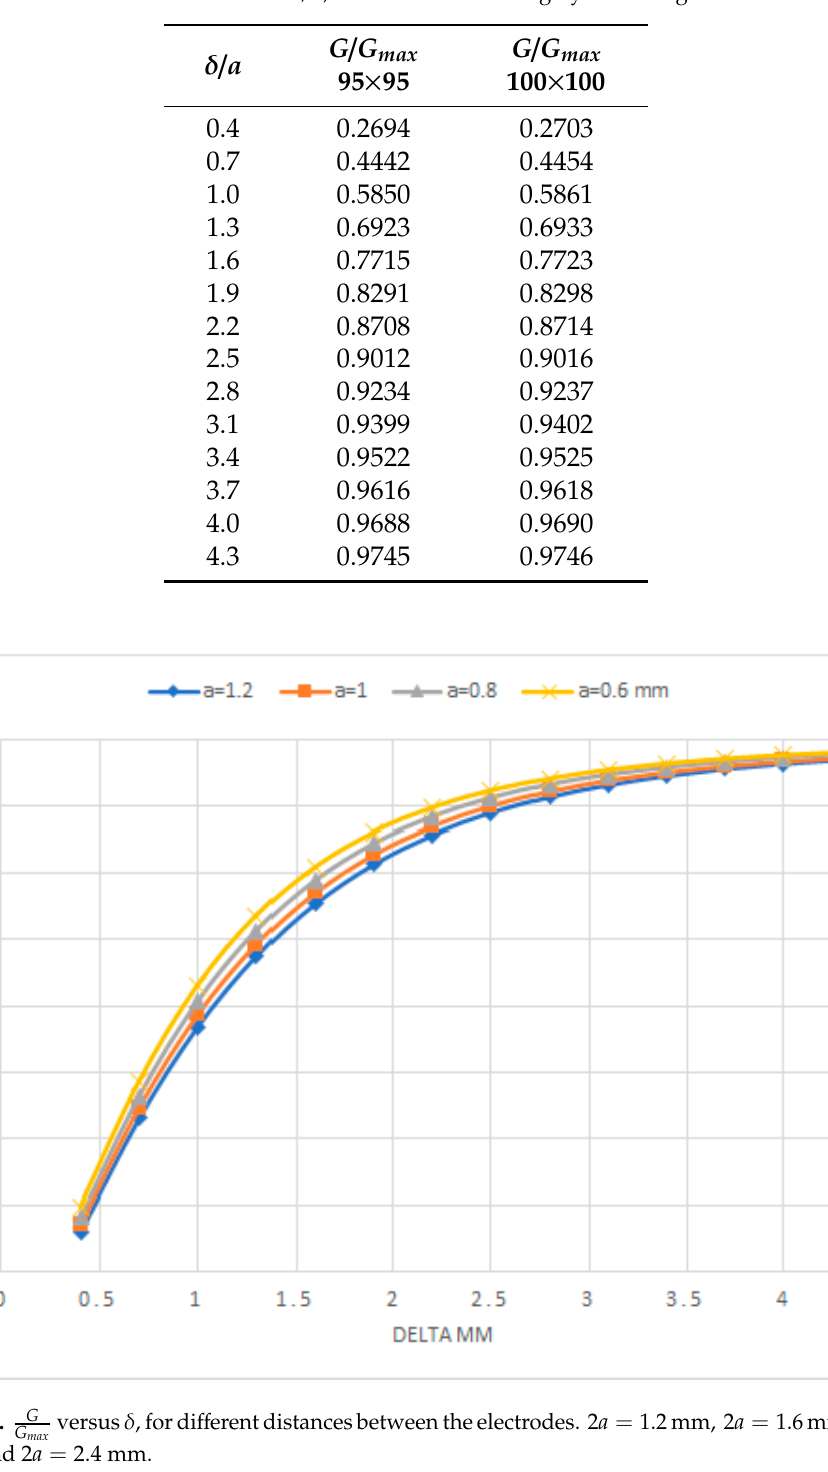
Table 1. Relative conductance G / G max , computed with n max = 95, and m max = 95, and wit n max = 100, and m max = 100 for di ff erent values of δ / a , for the case of curve grey line of Figure 8.